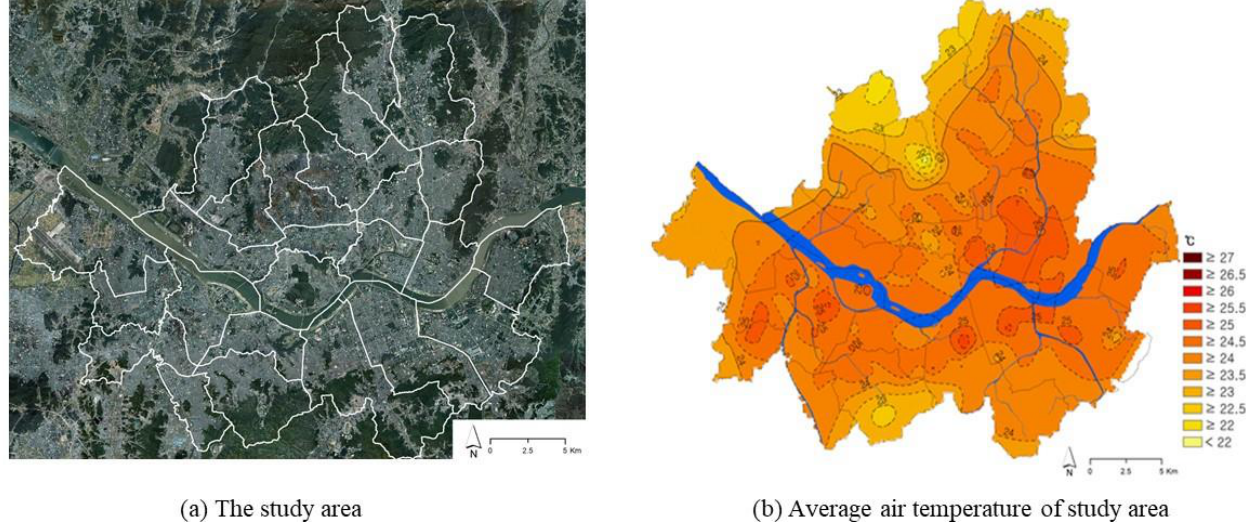
Figure 4. The study area (Seoul, South Korea). ( a ) Satellite image (Source: http://maps.kakao.com, accessed date: 20 August 2020) and administrative boundary. ( b ) Distribution of daily average temperatures of the study Area. (Source: Observation Data from Korea Meteorological Administration (public) and SK teckX (private) Automated Weather Systems; no precipitation in 2017; average daily cloud amount below 3; the average air temperature of the nine days when the average wind speed is below 5.4 m/s).